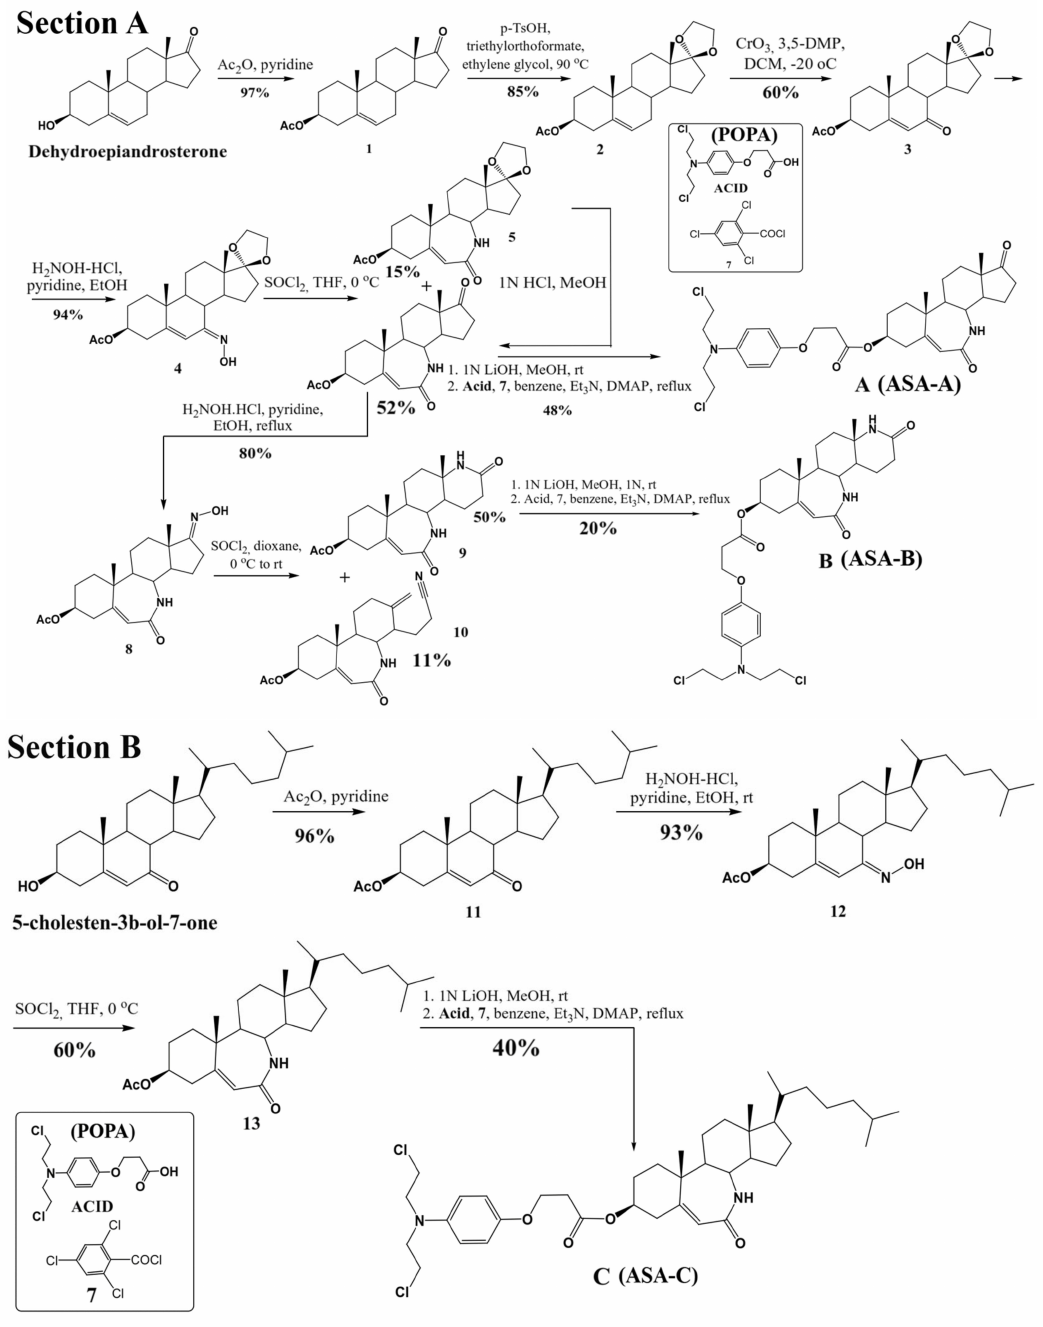
Figure 1. Schematic outlining the synthetic procedure and respective chemical reaction yields of B-homo-aza (lactam)- alkylator (ASA-A), B,D-homo-aza (bilactam)-steroid alkylator (ASA-B) derived from dehydroepiandrosterone ( Section A ) and B-homo-aza (lactam)-alkylator (ASA-C) derived from 5-cholesten-3b-ol-7-one ( Section B ), esterified with the alkylating acid 3-{4-[bis (2-chloroethyl) amino] phenoxy}propanoic acid